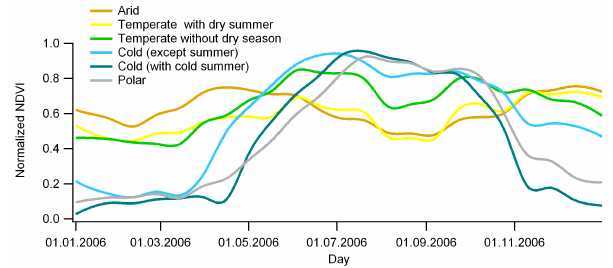
Fig. 3. Temporal evolution of average normalised NDVI in the six Fig. 3 : Temporal evolution of average normalised NDVI in the six climatic zones. climatic